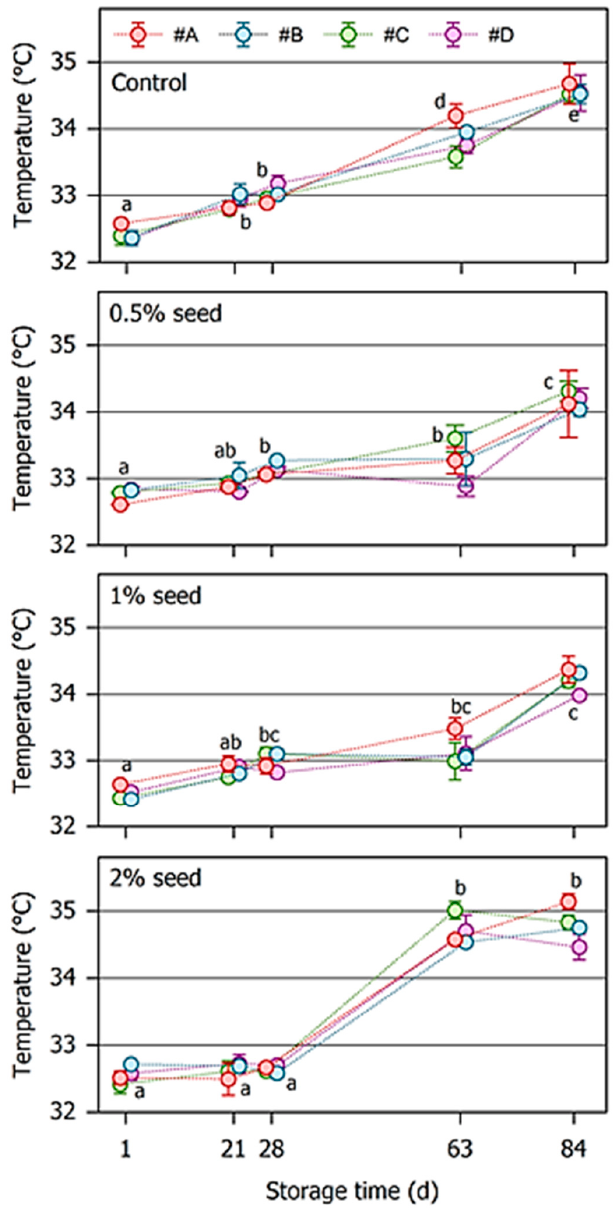
Figure 3. Development of the melting peak temperature of chocolate on top of the nougat/chocolate layer models during storage at 23 °C for 84 days. Four different nougats (#A, #B, #C, #D) were either tempered using the stir/shear technique (control) or seeded with different amounts of cocoa butter crystals. For the sake of clarity, symbols are slightly shifted along the x-axis. Individual data are arithmetic mean ± half deviation range of duplicate measurements. Mean values after different storage times labeled with different letters differ significantly ( p < 0.05).